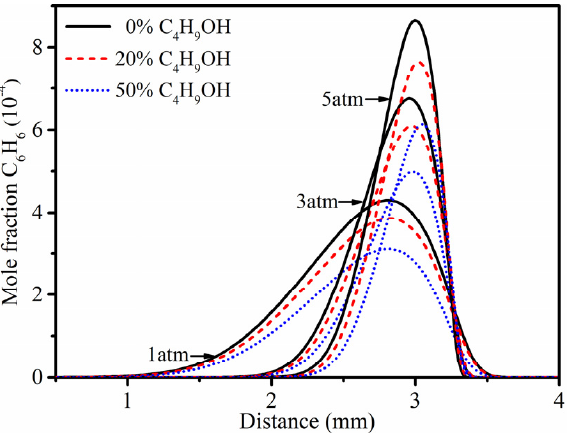
Figure 9. Mole fractions of C 6 H 6, with different levels of n -butanol at different pressures. On the contrary, with the increase in pressure, the concentrations of C 2 H 2 and C 6 H 6 increased, and the distributions moved toward the oxidizer side. The peaks of the C 2 H 2 distribution curve increased to a small degree and were not sensitive to pressure